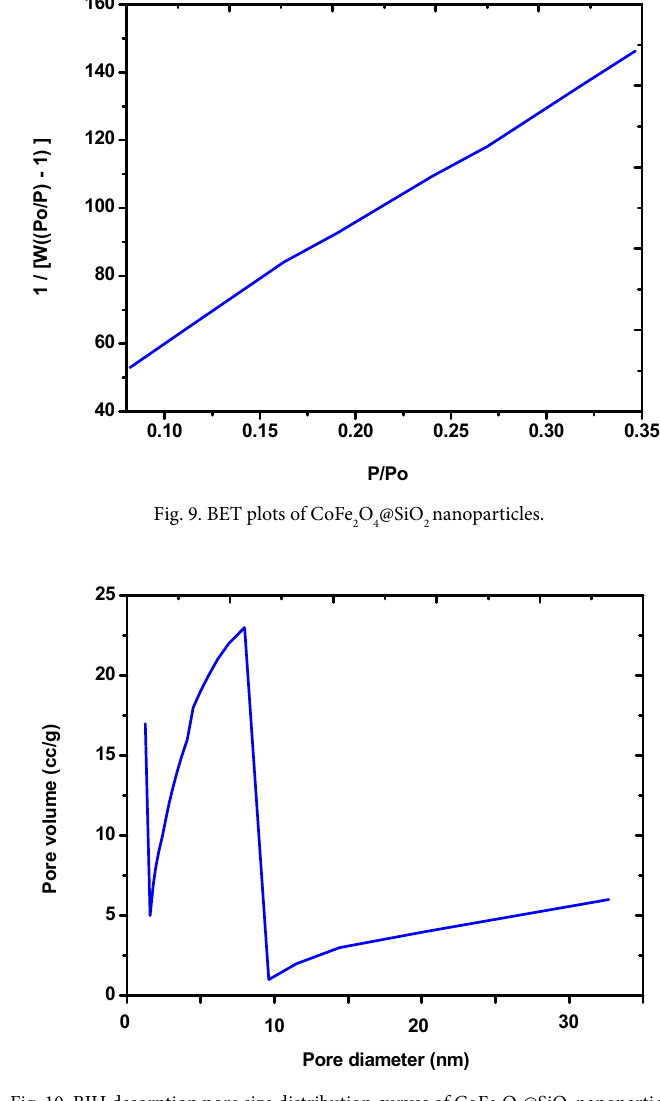
Figure 10 . BJH desorption pore size distribution curves of CoFe